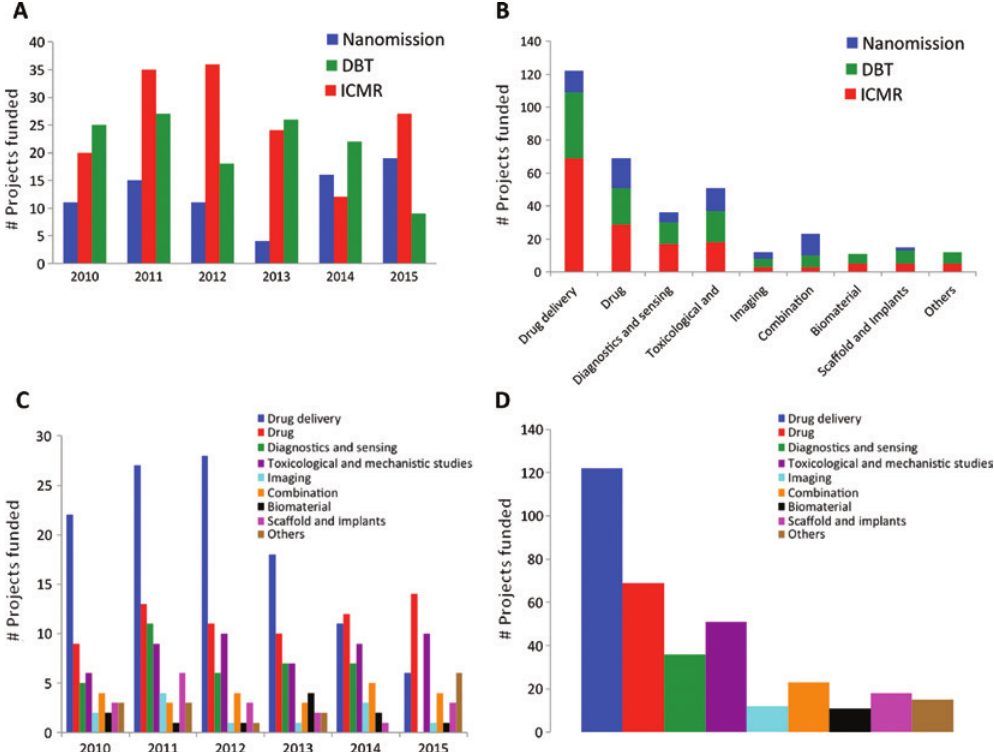
Figure 4: A comparison of number of projects supported by Nanomission, ICMR, and DBT over a period of 5 years. (A) Number of projects funded by Nanomission, ICMR, and DBT from 2010 to 2015. (B) Distribution of projects funded by Nanomission, ICMR, and DBT from 2010 to 2015 in different areas. (C) Areawise distribution of projects Nanomission, ICMR, and DBT from 2010 to 2015. (D) Areawise distribution of the total of Nanomission, ICMR, and DBT from 2010 to 2015 (source: compiled by authors from websites of DST, DBT, and ICMR).